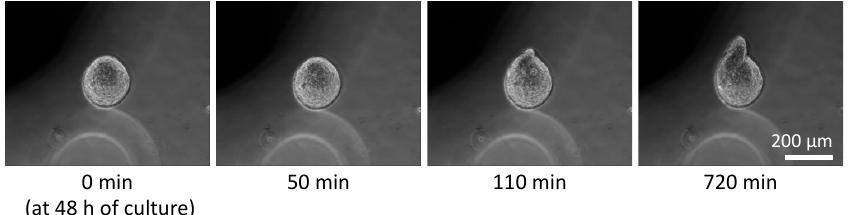
Figure 6. Time course of peculiar growth of tumor spheroids cultured in the 2.0% agarose gel. Scale bar: 200 µm.